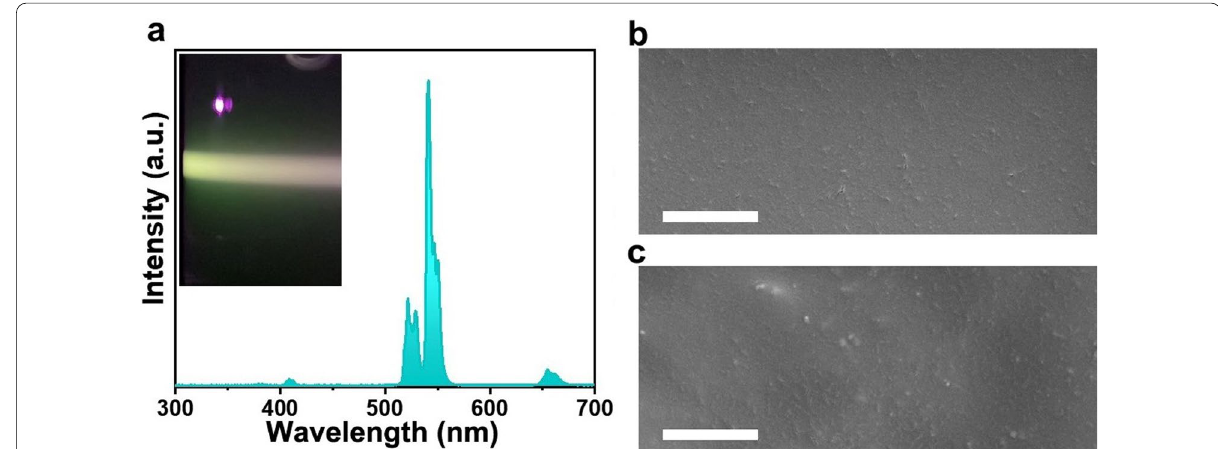
Fig. 4 a The upconversion fluorescence spectrum of ACI (solid content sustainable and invisible ACI being irradiated by an 808 nm NIR laser. SEM observations (scale bars ( b ) and ACI ( c ) on the surface of leather